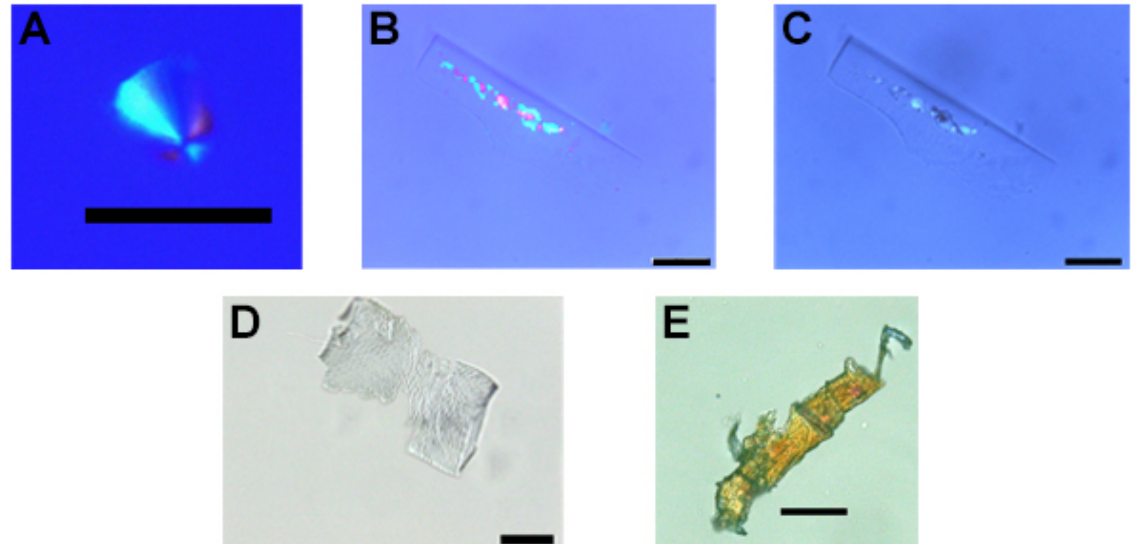
Figure 13. Elements found in sediment I (A-C) and sediment II (D-E) of the proximal area. A: Non-identified element. B-C: Possible phytolith. D-E: Vessel elements. Photos taken under bright field (C, D, E) and polarized (A, B) lights. Scale bar size: B-C, 20 µm; A, E, 50 µm; D, 100 µm. Photos by Rodrigo Angeles Flores.